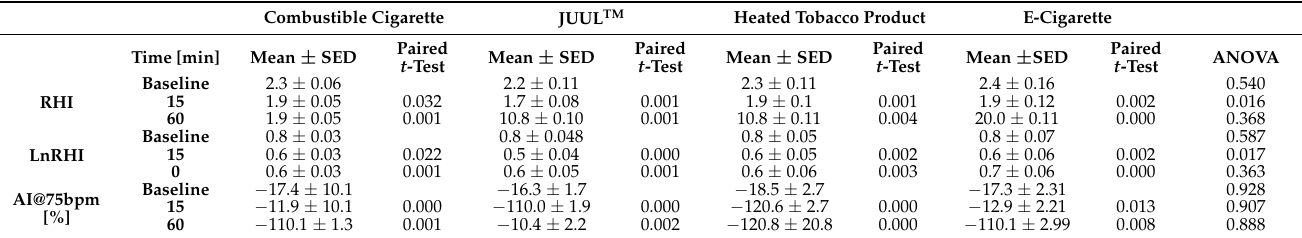
Table 2. Measurements of arterial stiffness represented by the reactive hyperemia index (RHI) and its natural logarithm (LnRHI) and endothelial vasodilator function represented by the augmentation index (AI) adjusted at a heart rate of 75 beats per minute (AI@75bpm).